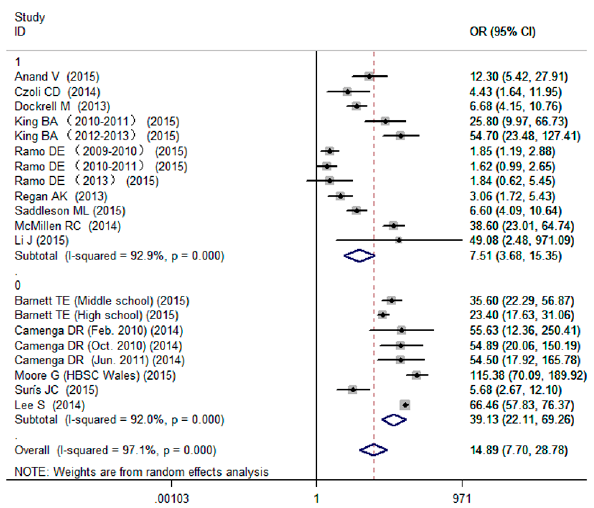
Figure 2. Effects of current smoking on current e-cigarettes use among adolescents and adults (0: adolescent 1: adult).